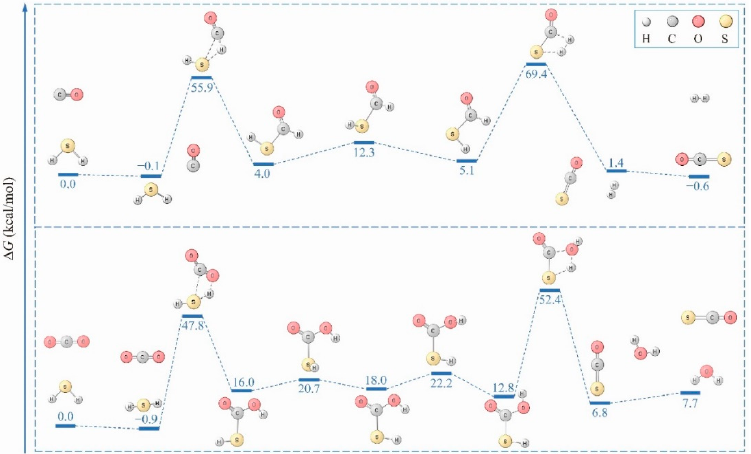
Figure 2. Reaction profiles for H 2 S + CO x ( x = 1, 2) (all energetics were refined by the CCSD(T) method). Although the H 2 S···CO 2 complex is the most stable species on the CO 2 + H 2 S PES, the reaction channels leading to the COS + H 2 O product were explored and are presented in Figure 2 (lower panel) and Figure S6. It is clear that the initial step of hydrogen transfer that occurs during CO 2 reduction is energy demanding (48.7 kcal·mol − 1 ), which is compa- rable to the value of 49.6 kcal·mol − 1 reported in a previous study [11]. Additionally, the step for COS···H 2 O production is difficult at low temperatures. With an efficient catalyst [14], these barriers can be reduced significantly. However, the conversion of CO x to COS makes it less likely that the CO x hydrogenation reaction will occur. Furthermore, the ac- tive hydrogens are lost in the form of H 2 or H 2 O. Interestingly, when H 2 S is replaced with HSiSH, disparate behaviors are predicted toward CO x activation. In the case of CO, a global minimum with a four-membered ring can form through concerted double hydro- gen transfer from HSiSH to CO (Figure 3). Since the hydrogen transfer involves simulta- neous HSiSH dehydrogenation and CO hydrogenation, “coupled reaction pathway” is employed here to denote it. If the hydrogen is released (from HSiSH) instead, “decoupled reaction pathway” is more appropriate. In the coupled reaction pathway, an alternative step to produce the kinetically more stable SiS + HCHO is clear. However, competitive channels for hydrogen release (in the decoupled reaction pathway) are, from an energetic point of view, more effective (Figure 3, lower panel), and CO even acts as a catalyst in this reaction. As can be inferred from the figure, the Gibbs free energy barrier for two-step dehydrogenation is about 18.8 kcal·mol − 1 on average while that for one-step dehydrogena- tion amounts to 34.8 kcal·mol − 1 . In other words, the thermodynamically favored hydrogen transfer reaction to reach the global minimum is decoupled or at least partially decoupled for H 2 production. As for the global minimum for CO 2 , the two pathways toward its for- mation are presented in the SI (Figure S13), and the rate-limiting step is appreciably higher: at least 57.7 kcal·mol − 1 at the M06-2X/aug-cc-pVTZ level, revealing the difficulties in its generation.